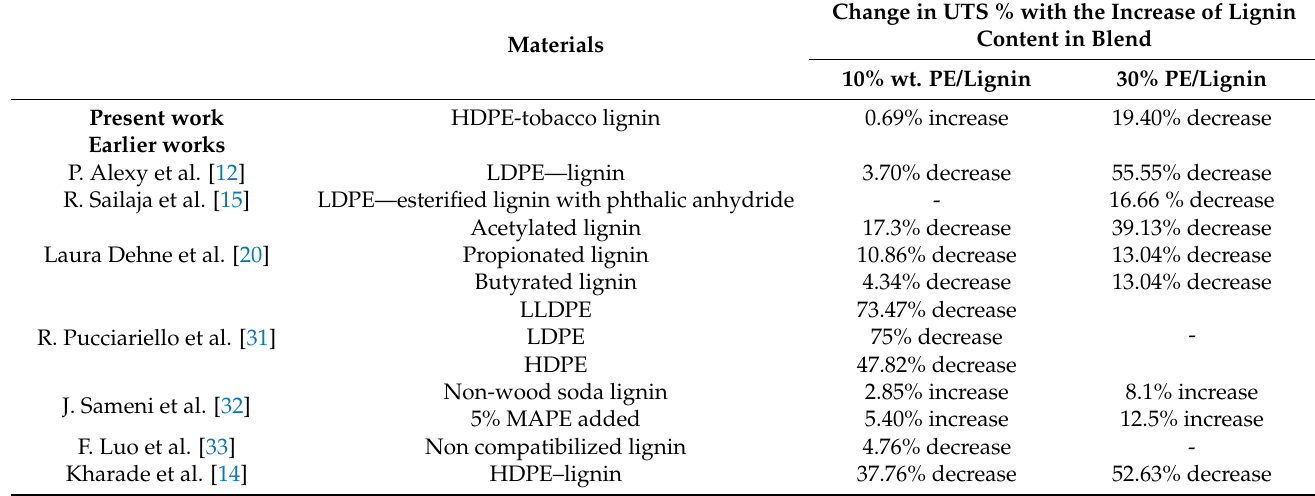
Table 6. Comparison of UTS for HDPE–lignin blends in related works.